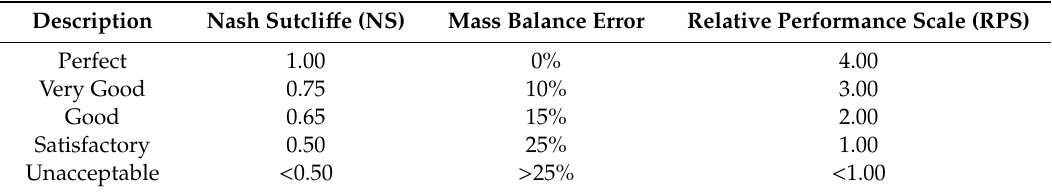
Table 2. The Relative Performance Scale